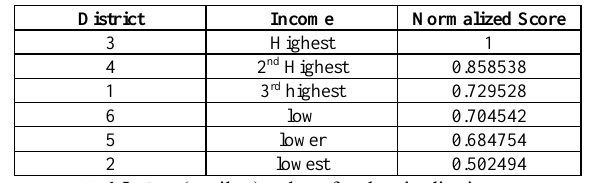
Table 2. ε (epsilon) values for the six districts.